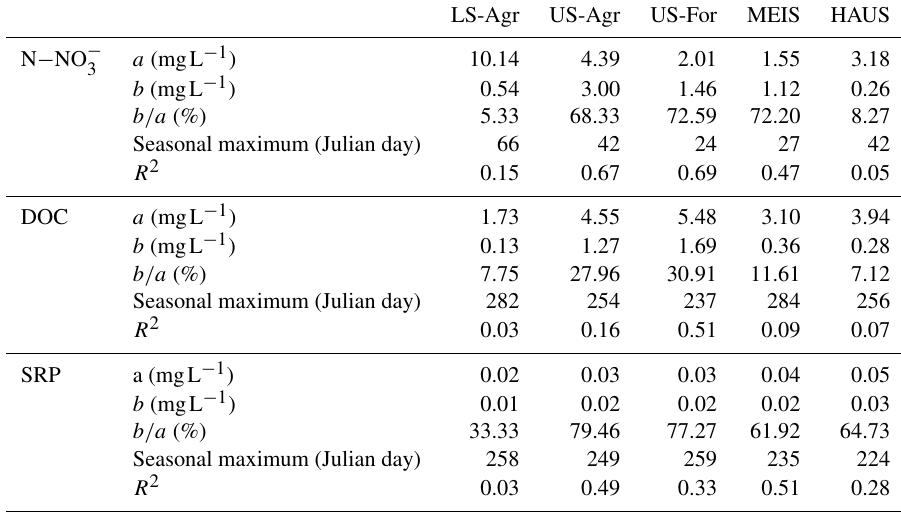
Table 2. Coefficients of the cosine equation fitting to grab sampling concentration data.